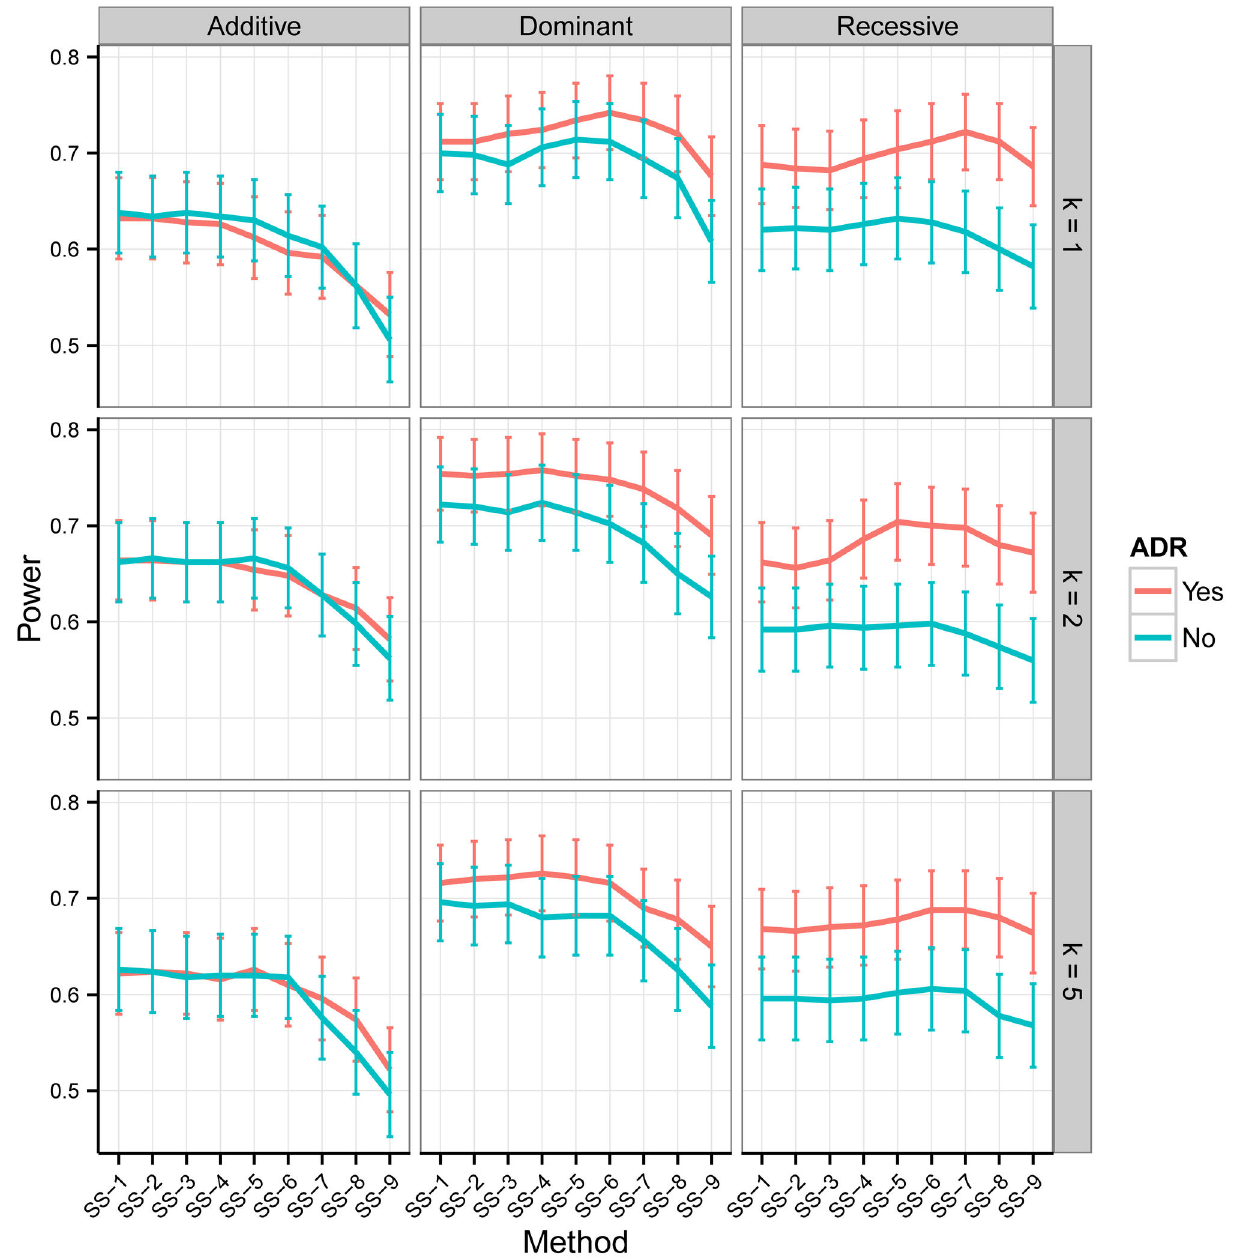
Figure 2. Empirical power of SS-T methods under Experiment II as a function of the mode of inheritance, the number of causal variants in a LD block ( k ) and the ADR adjustment status. The nominal type I error rate is α =0.05. The bars represent the 95% confidence interval for the power of test. See Figure 1 for background and